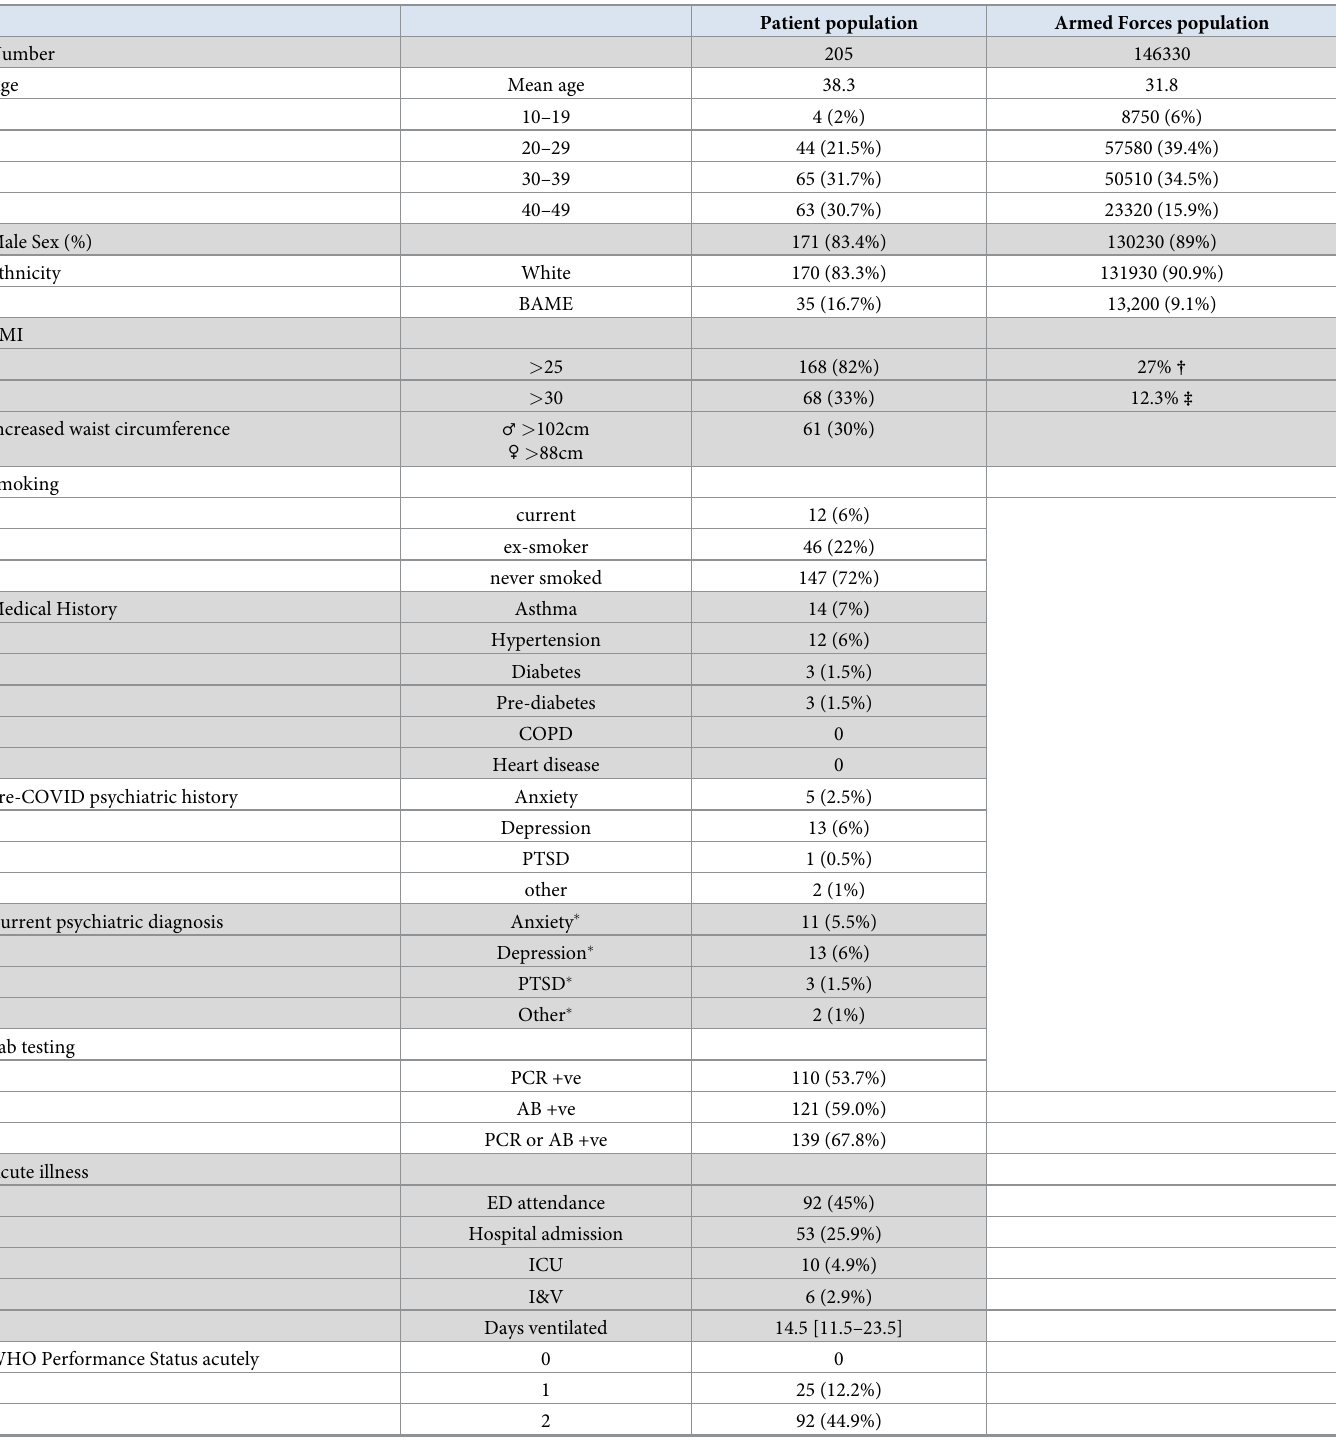
Table 3. Baseline characteristics of DCRS